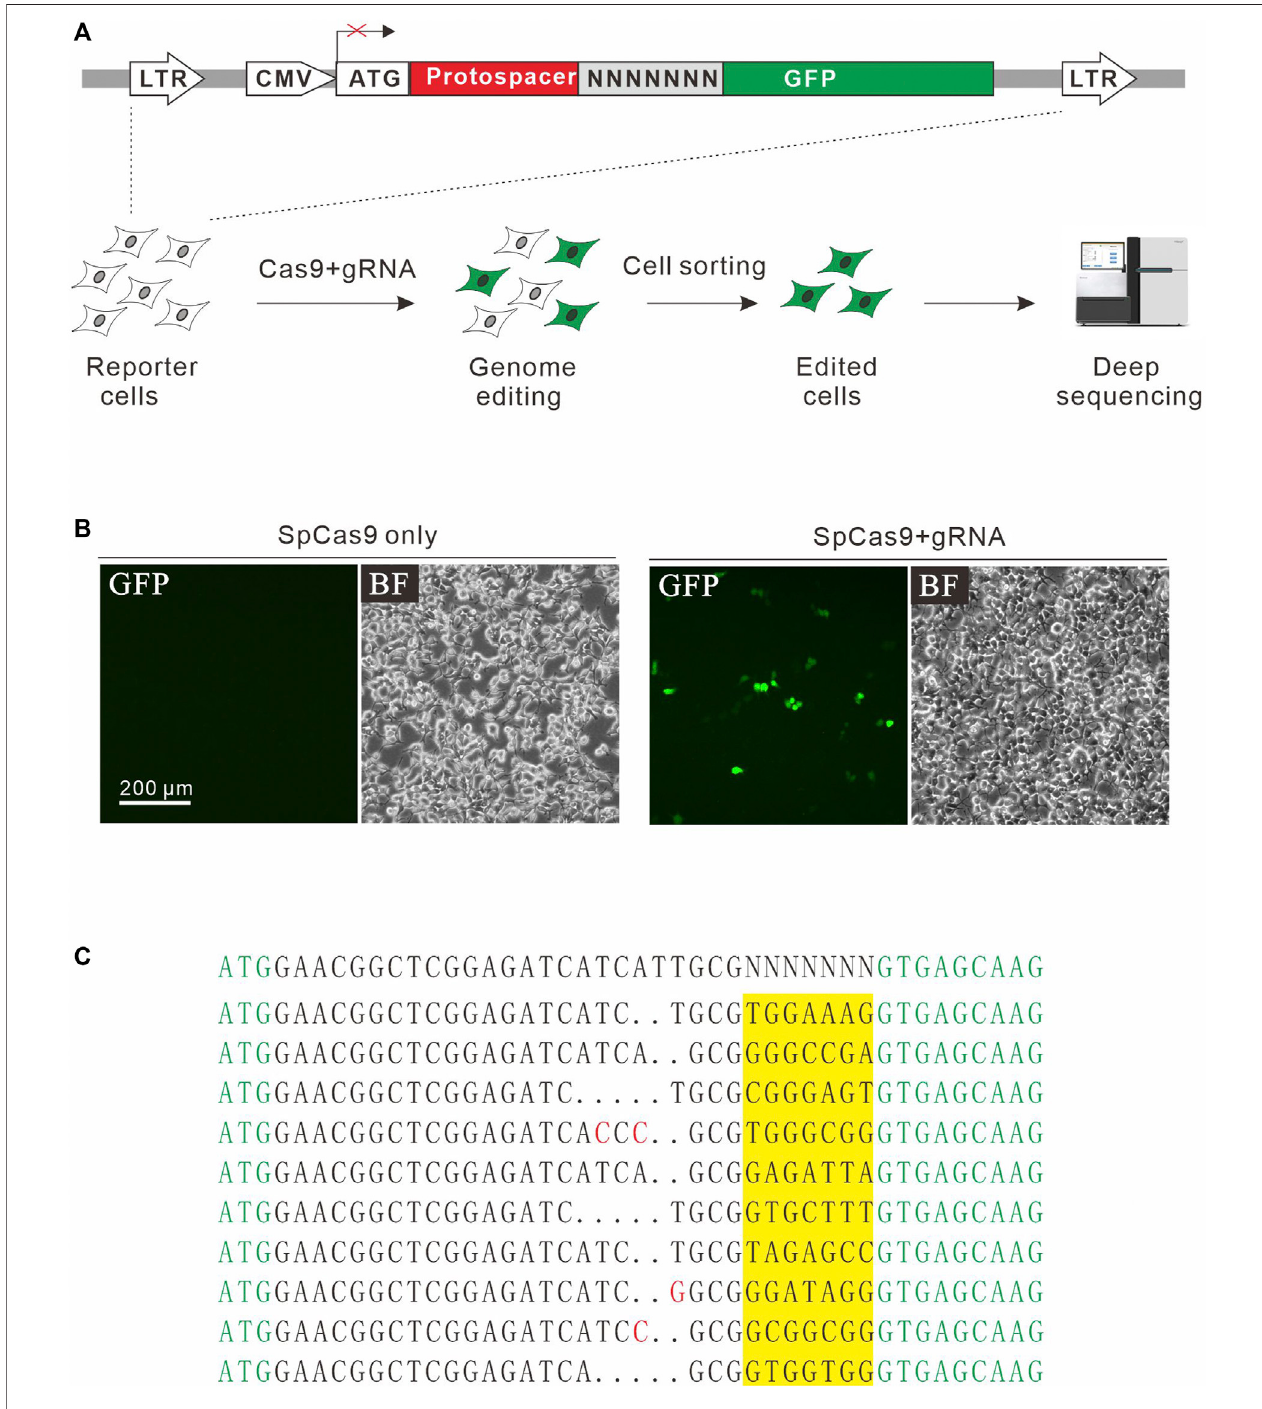
FIGURE2| AGFPactivation assayforPAMscreening. (A) SchematicdiagramoftheGFPactivationassay.Alentiviral vectorcontainsaCMV-driven GFP.Atarget sequence followed by a 7-bp random sequence is inserted between ATG and GFP coding sequence, disrupting GFP expression. The library is stably integrated into HEK293Tcells.Aftergenomeediting,aportionofcellswillrestoreGFPexpression.GFP-positivecellsaresortedoutandPAMsequenceswerePCR-ampli fi edfordeep- sequencing analysis. (B) Transfection of Sp Cas9 and gRNA results in GFP expression, while transfection of Sp Cas9 alone cannot induce GFP expression. (C) Deep-sequencing reveals that targets with multiple PAMs can be edited. GFP sequence is shown in green; insertion mutations are shown in red; 7-bp random sequences are a highlight in yellow.